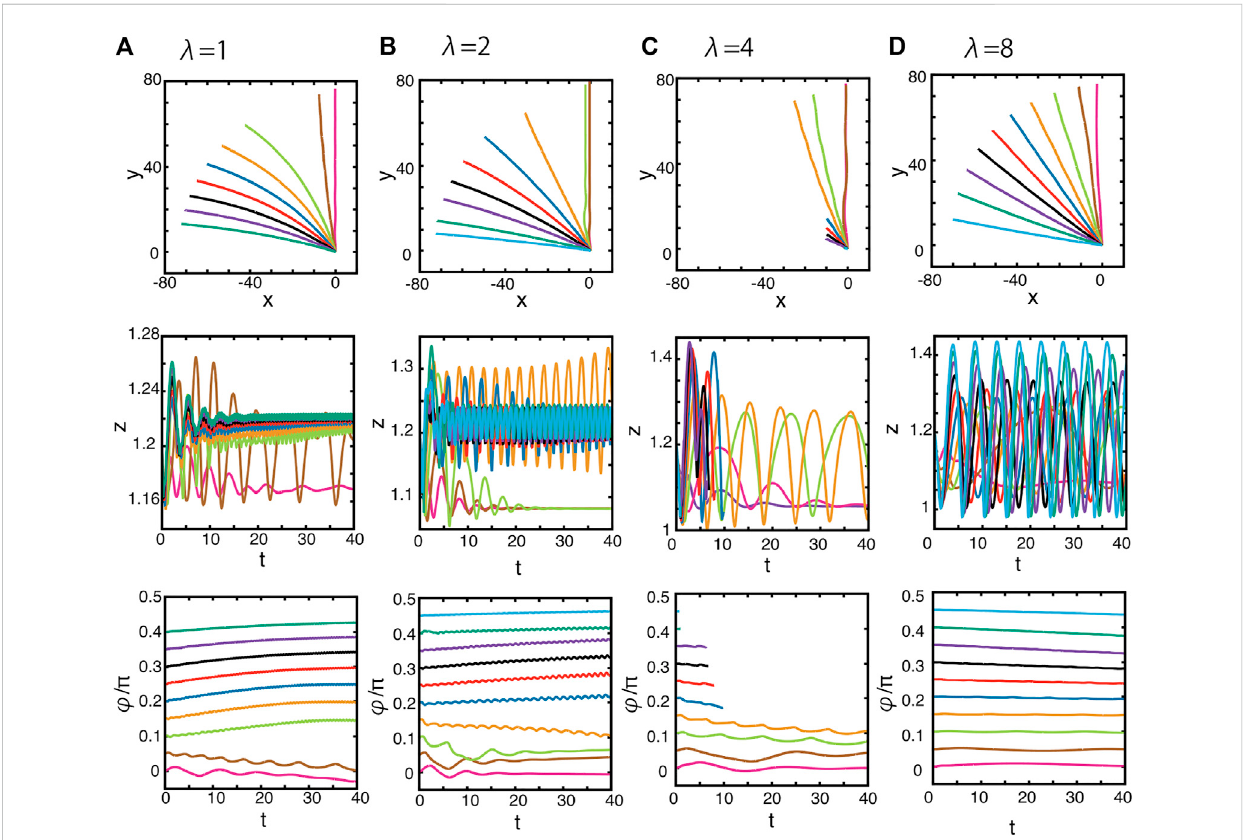
FIGURE 7 Dynamics of the squirmer near a surface with the singly periodic sinusoidal wave topography of Eq. 4 and Figure 2A. The surface topography amplitudeisgivenby A =0.1,andthewavelengthis (A) λ =1, (B) λ =2,and (C) λ =4, (D) λ =8.(Toppanels)theprojectionsofthesquirmertrajectoriesonto the x – y plane with different initial orientation angles, φ , as de fi ned via Figure 5. These initial angles may be inferred from the initial tangents of the plotted projected trajectories. (Middle panels) the time evolution of the height of the centre of the squirmer, z . (Bottom panels) the time evolution of the orientation angle φ . Different colours index different initial values of the orientation angle, φ